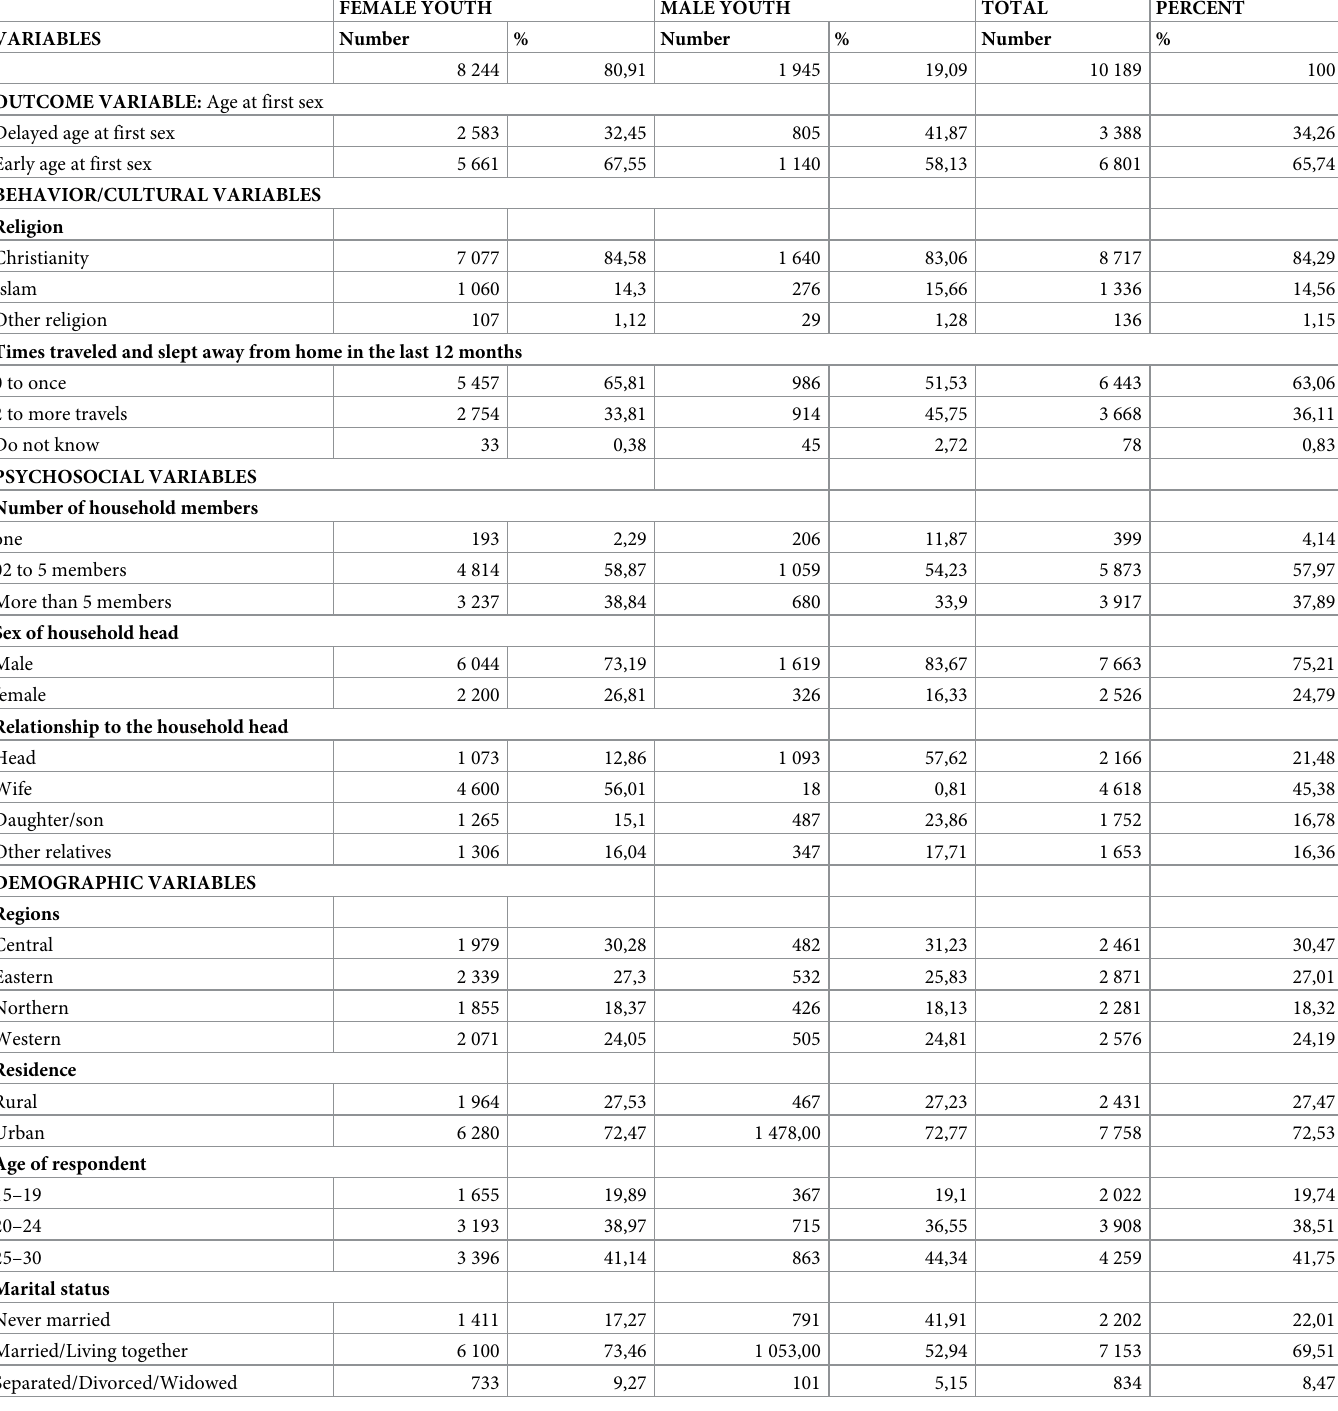
Table 2. Weighted descriptive characteristics of the study population and age at first